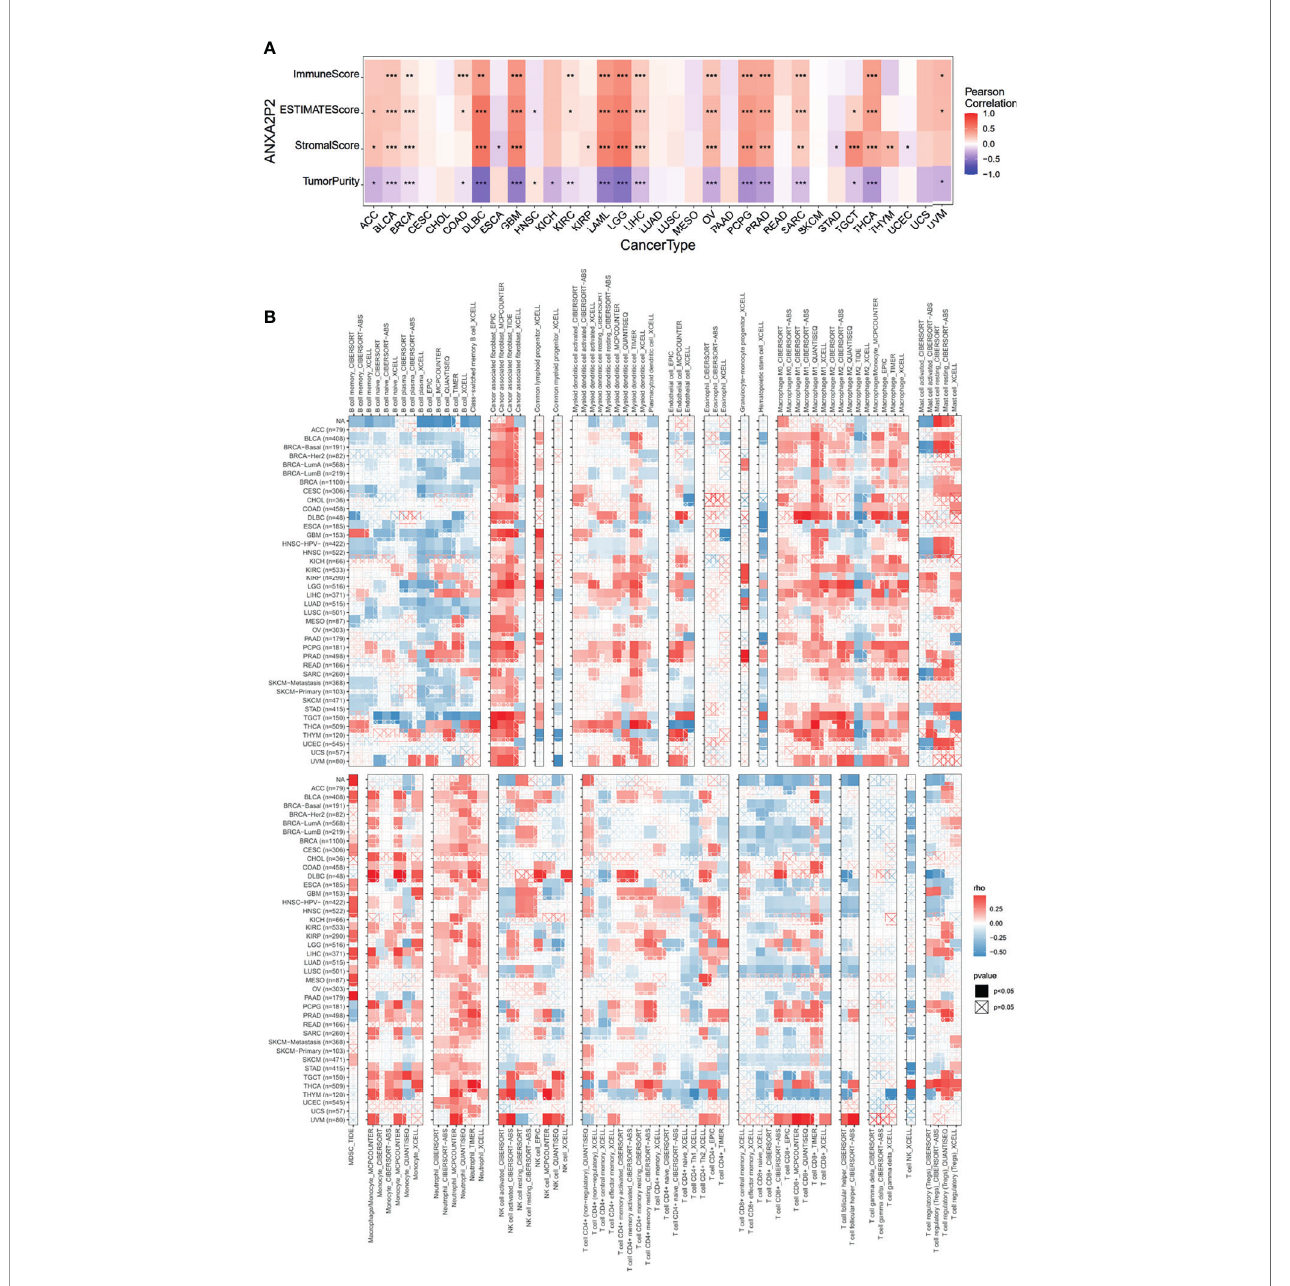
FIGURE 5 | Correlation analysis of ANXA2P2 to ESTIMATE-related score and to immunocyte on the TIMER database. (A) The heatmap of correlation of ANXA2P2 to immune score, estimate score, stromal score, and tumor purity. (B) Relevance of ANXA2P2 expression to immune in fi ltration in pan-carcinoma. *P < 0.05, **P < 0,01 and ***P <